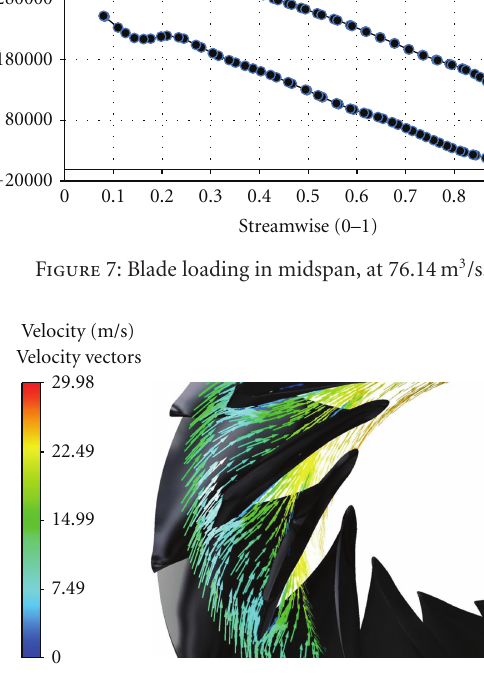
Figure 8: Velocity vectors at